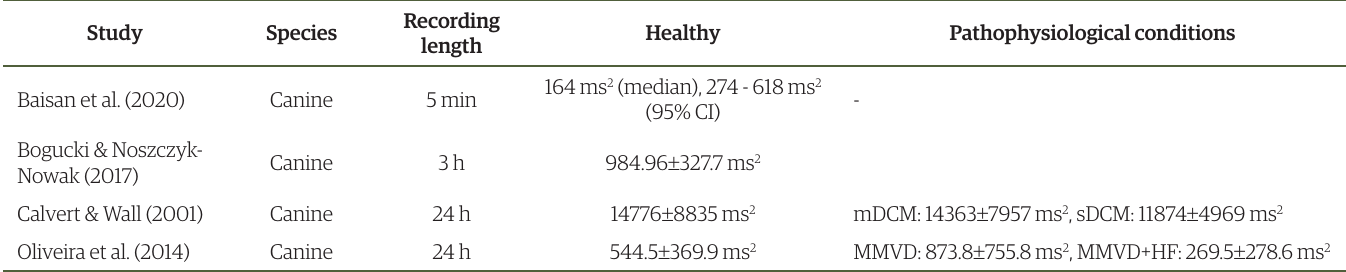
Table 7. Summary results of selected studies from the literature, depicting the recording length for data acquisition and the VLF values for healthy animals or those presenting pathophysiological